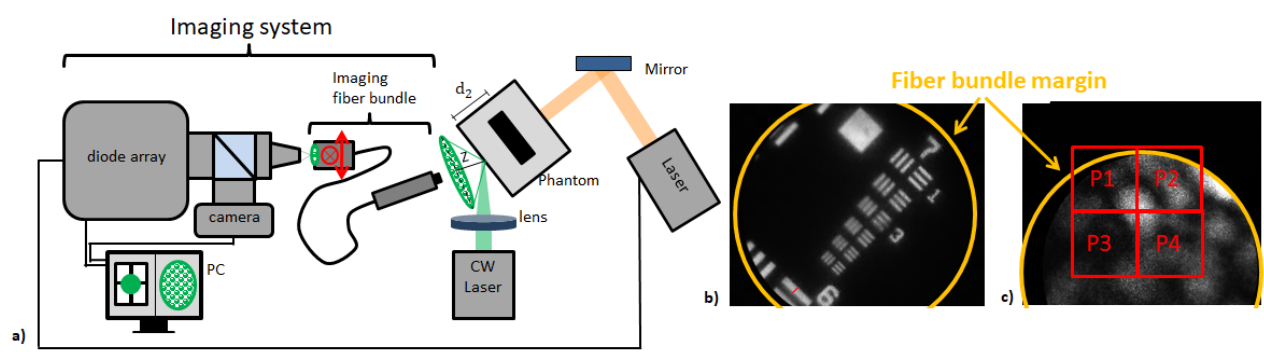
Figure 4. Experimental setup and imaging unit for the remote photoacoustic measurements using the fiber based approach ( a ). The proximal fiber bundle end can be moved in lateral directions, which is indicated by the red marks. The magnification for the camera arm is determined at 50 using a USAF 1951 Test Target ( b ). A convenient speckle that is centralized inside the photodiode measurement area is illustrated ( c